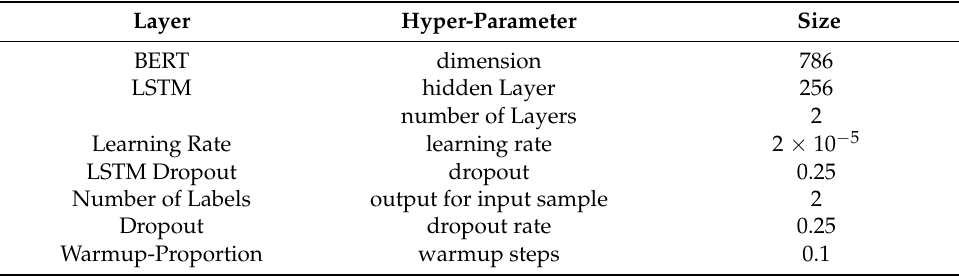
Table 3. Hyper-Parameters Used in Experiments. Layer Hyper-Parameter Size BERT dimension 786 LSTM hidden Layer 256 number of Layers 2 Learning Rate learning rate 2 × 10 − 5 LSTM Dropout dropout 0.25 Number of Labels output for input sample 2 Dropout dropout rate 0.25 Warmup-Proportion warmup steps